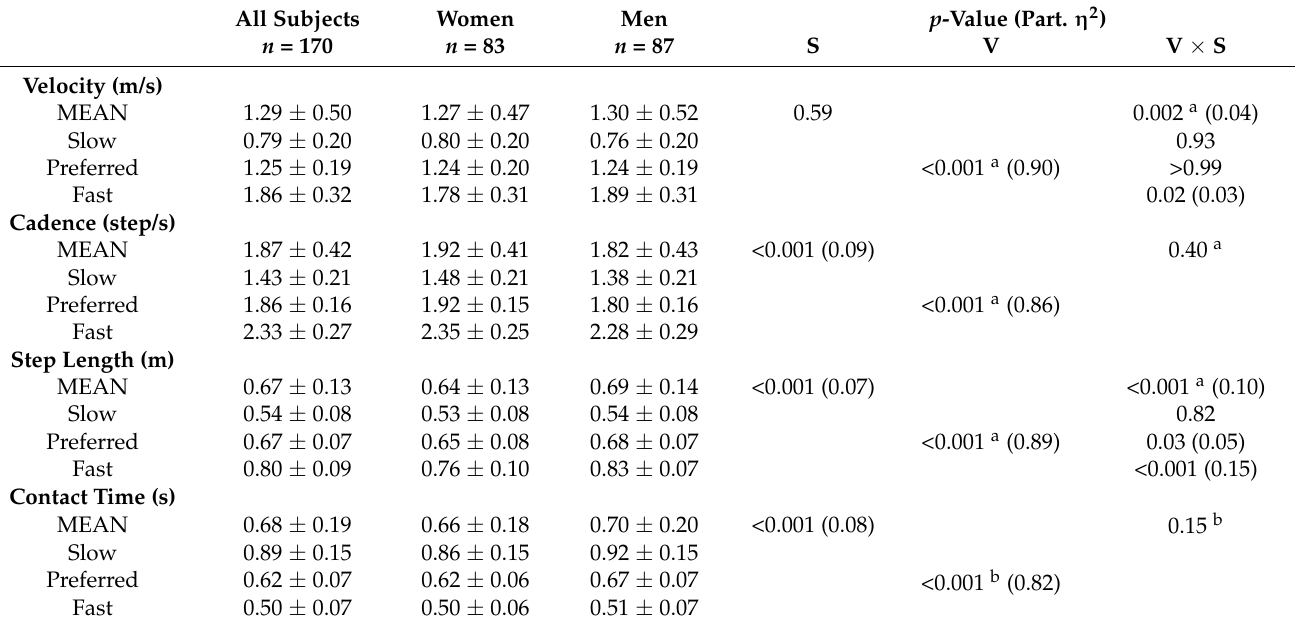
Table 2. Mean ± SD of spatiotemporal parameters for all subjects, women and men at the three different velocity conditions and their mean (appearing in a boldface type). p -values in the first column (S) indicate mixed-model ANOVA sex effect. In the second column (V), p -values indicate the result of mixed-model ANOVA velocity effects. In the third column (V × S), results of mixed-model ANOVA velocity-sex interaction are displayed (first row) and associated, when significant, with post-hoc Tukey test comparing men and women at each specific velocity (rows in line with speed data). Partial eta-squares (part. η 2 ; with part. η 2 ≈ 0.01 indicating a small effect, part. η 2 ≈ 0.06 indicating a medium effect and, part. η 2 ≈ 0.14 indicating a large effect) are reported as effect size (in